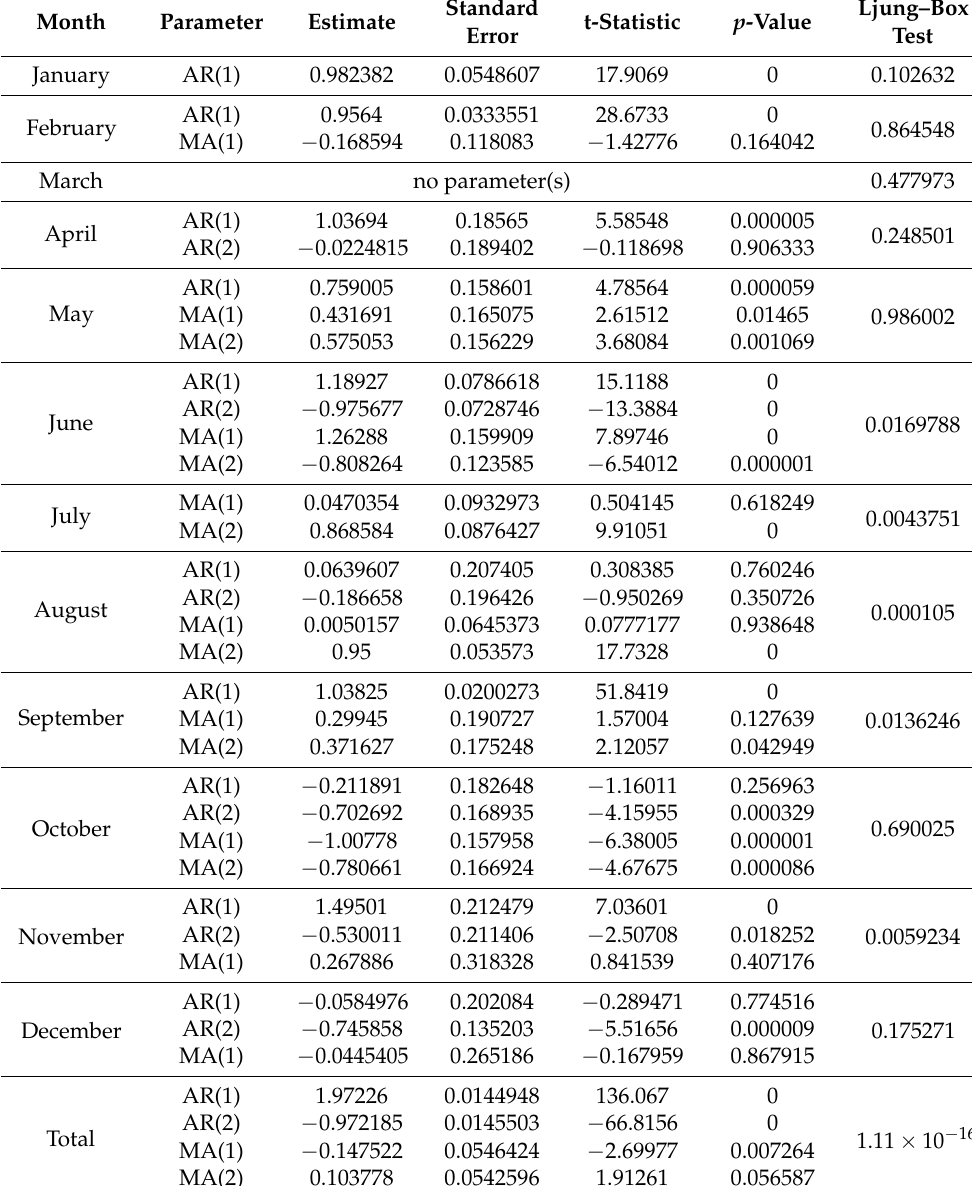
Table 2. ARIMA models